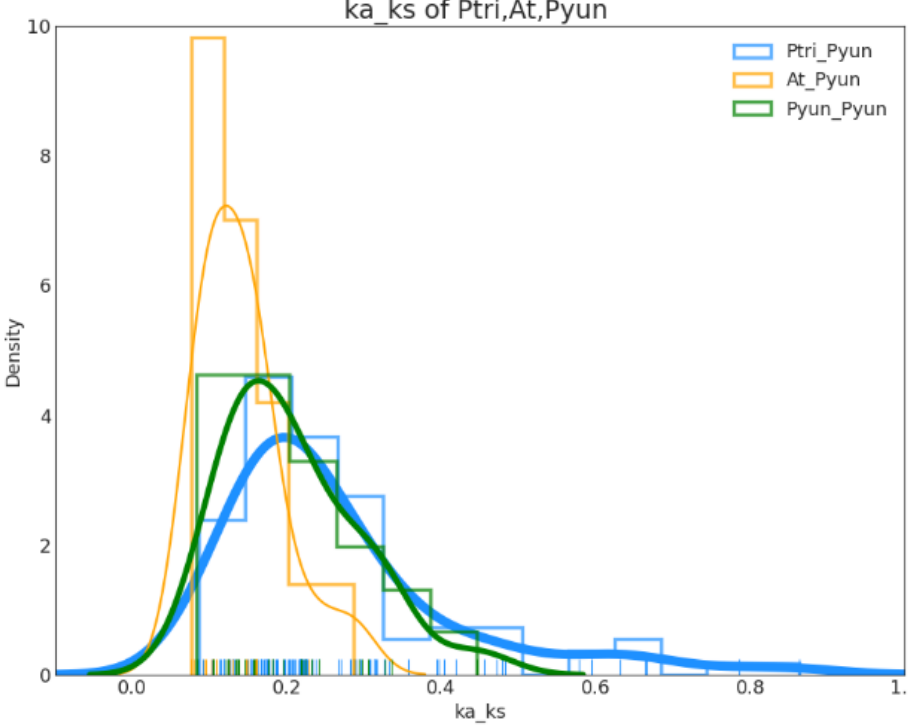
Figure 6. Ka/Ks ratios of collinear PyuARFs in P. trichocarpa , P. yunnanensis , and A. thaliana . Blue curves represent the Ka/Ks ratios of collinear ARF genes in P. trichocarpa and P. yunnanensis . Yellow curves represent the Ka/Ks ratios of collinear ARF genes in P. yunnanensis and A. thaliana . Green curves represent the Ka/Ks ratios of collinear ARF genes in P. yunnanensis and P. yunnanensis.